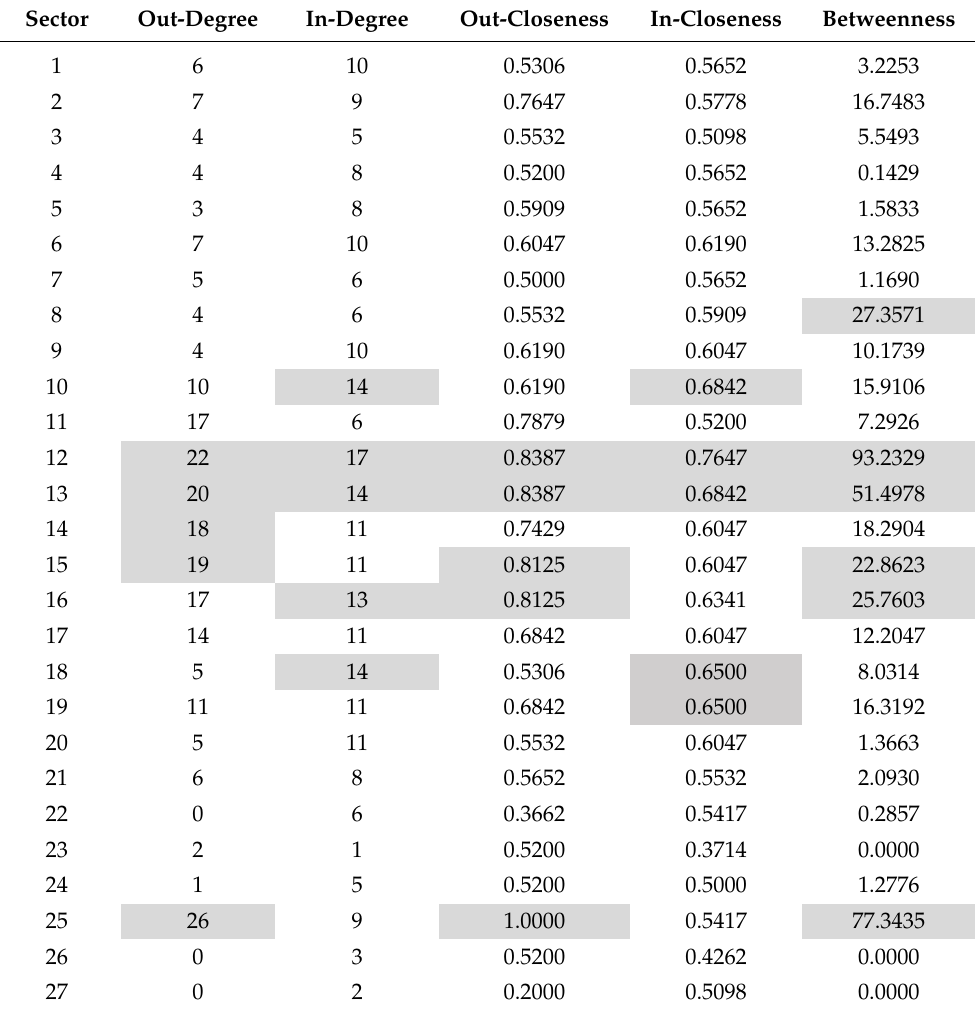
Table 8. The degree, closeness and betweenness of PM metabolic